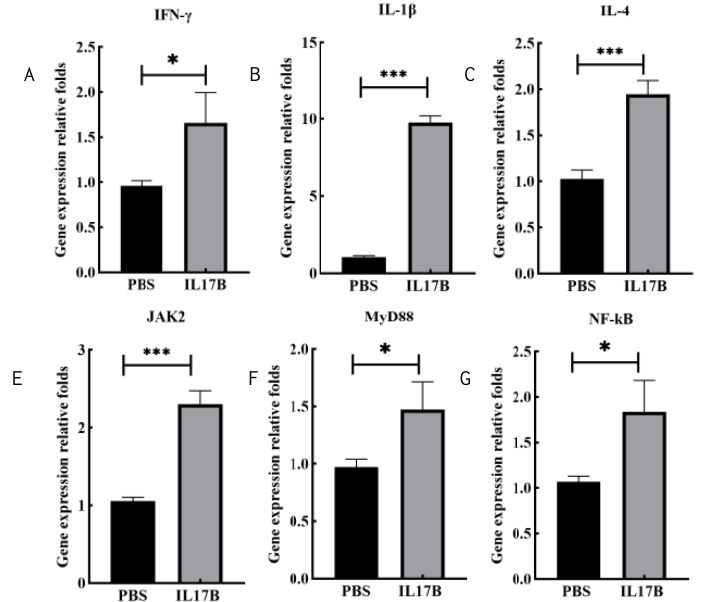
Figure 8. The expression levels of the immune-related genes in DF-1 cells treated using the recombinant protein chIL-17B expressed in duckweed. ( A – C , E – G )The expression levels of MyD88, NF- κ B, IFN- γ , IL-1 β , JAK2, and IL-4 in ChIL-17B-stimulated DF-1 cell. The statistical analysis was performed using the t test in GraphPad Prism 8. *: p < 0.05, ***: p < 0.001.